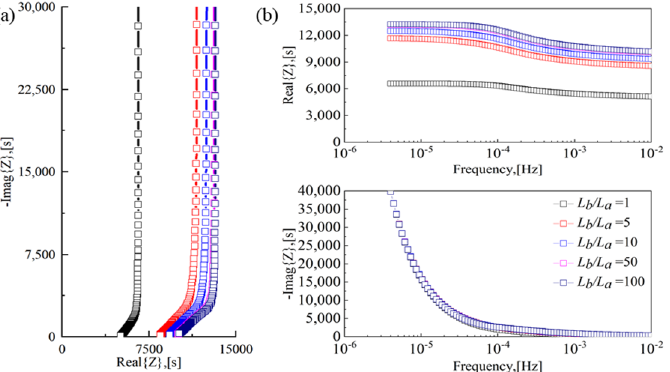
Figure 4. Impedance spectroscopy of different width-to-thickness ratios (Bi = 1). ( a ) Nyquist figure, ( b ) variation curve of real part and imaginary part with frequency.